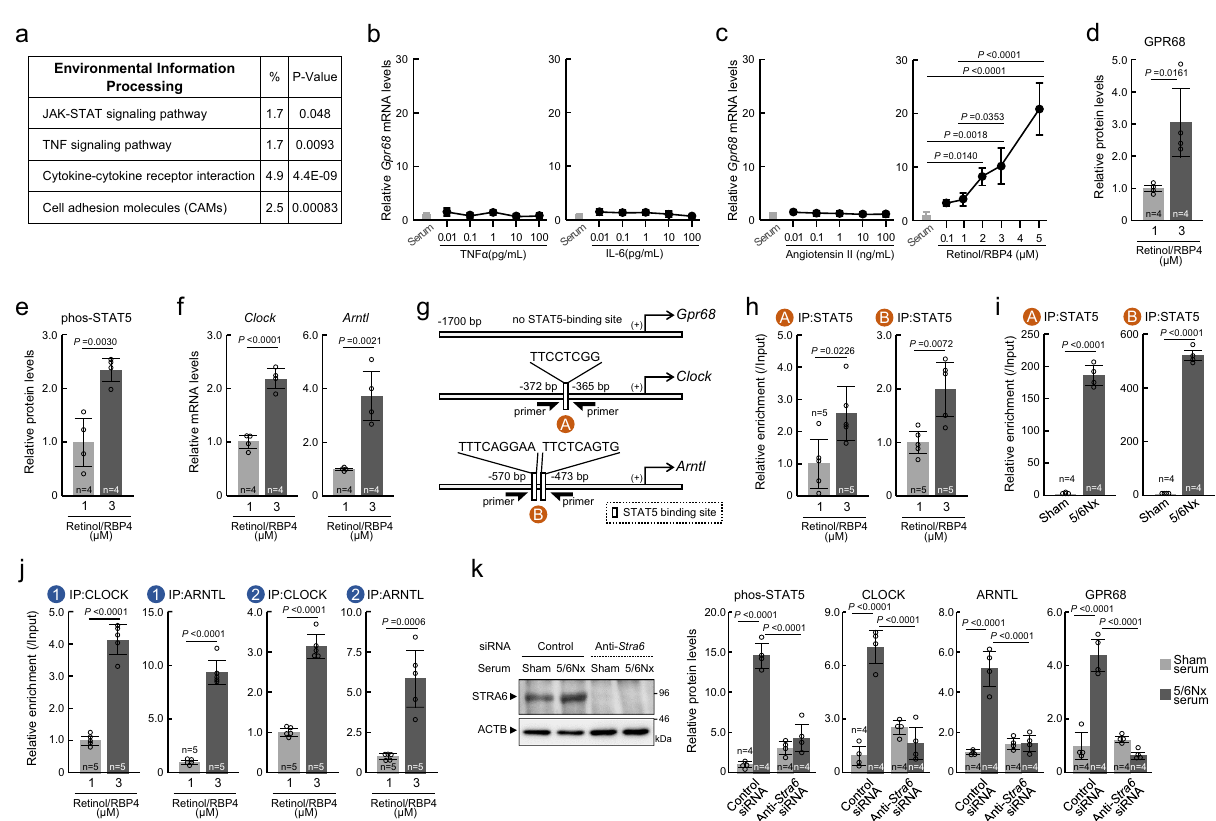
Fig. 6 Increased serum retinol levels induce GPR68 expression in monocytes. a Functional analysis of the genes using the KEGG database. Detailed data are presented in Supplementary Table 5. b , c The mRNA levels of Gpr68 in mouse primary cultured monocytes after treatment with TNF α , IL-6, angiotensin II, or retinol/RBP4 at the indicated concentrations for 24 h. d – f The protein levels of GPR68 and phosphorylated STAT5 (phos-STAT5), and the mRNA levels of Clock and Arntl in mouse primary cultured monocytes after treatment with 1 or 3 µ M of retinol/RBP4 for 24 h. g Schematic representation of the upstream region of the mouse Gpr68 , Clock , and Arntl genes. The numbers indicate the distance from the transcription start site ( + 1). The circled letters (orange circles) indicate the location on the gene where each of the different primer sets localize for analysis of ChIP. h , i ChIP analysis of retinol/RBP4- induced changes in the binding amount of STAT5 protein to the upstream region of Clock and Arntl genes in mouse primary cultured monocytes or the collected monocytes prepared from Sham and 5/6Nx mice. The primer sets used qPCR are illustrated in g . j ChIP analysis of retinol/RBP4-induced changes in the binding amount of CLOCK and ARNTL protein to the upstream region of Gpr68 genes in mouse primary cultured monocytes. Using primer sets illustrated in Fig. 5d. k Left panel shows the protein levels of STRA6 in monocytes transfected with siRNA against STRA6 (uncropped images are presented in Supplementary Fig. 21). Right panels show STRA6-dependent phosphorylation of STAT5 and expression of GPR68, CLOCK, and ARNTL by serum from Sham and 5/6Nx mice in mouse primary cultured monocytes. For all panels, graphs show the mean ± SD of individual mice in independent experiments ( h , j n = 5; the others n = 4 for each group). Statistical signi fi cance was determined using one-way ANOVA with Dunnett ’ s post hoc tests ( c ), two-tailed Student ’ s t -tests ( d – f , h – j ), or two-way ANOVA with Tukey – Kramer post hoc tests ( k ). Numbers and P -values are shown in the graph. Source data are provided as a Source Data fi